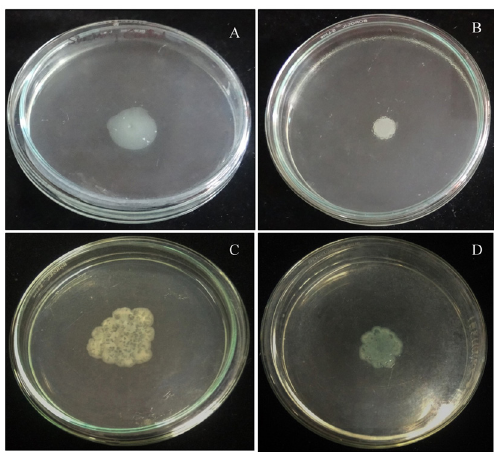
Fig. 2. Effect of sub-MIC dose (500 µg/ml) of P. tenuiflorus extract on the inhibition of bacterial motility (swimming and swarming) as compared to untreated control. (A) Swimming motility of untreated P. aeruginosa PAO1, (B) Swimming motility of P. tenuiflorus treated P. aeruginosa PAO1, (C) Swarming motility of untreated P. aeruginosa PAO1, (D) Swarming motility of P. tenuiflorus treated P. aeruginosa